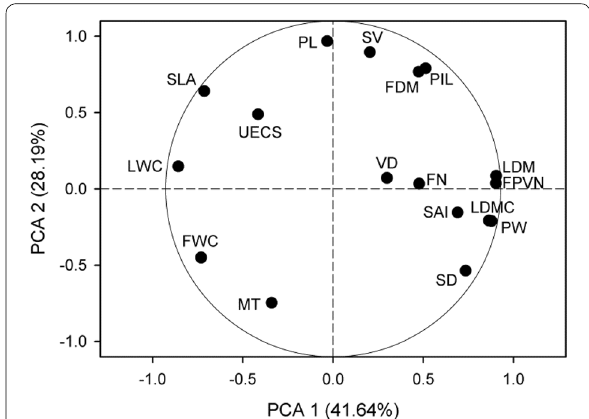
Fig. 2 Principal component analysis (PCA) of species mean values of Dendrobium plant traits. LDM leaf dry mass, LWC leaf water content; LDMC , leaf dry matter content, SLA specific leaf area, MT mesophyll thickness, UECS upper epidermal cell size, SD stomatal density, SV stomatal volume, SAI stomatal area index, VD vein density, PL